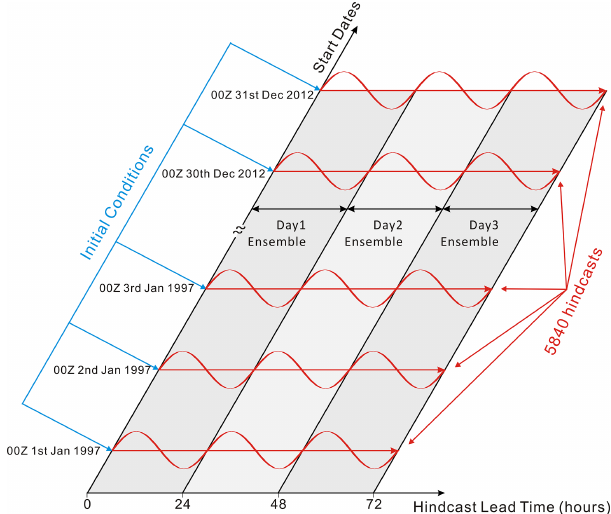
Figure 1. Schematic diagram for the multi-year hindcast procedure (modified from Ma et al., 2015) applied to series of 3d hindcasts from 1997 to 2012. Each hindcast is initialized with ERA-Interim reanalysis, and the starting time is 00:00Z every